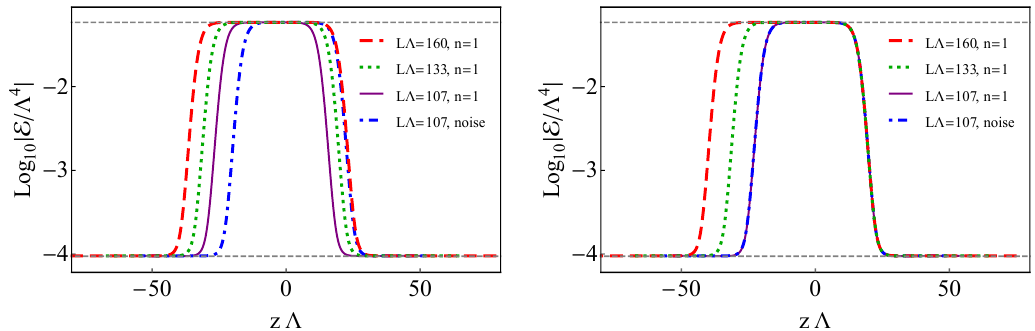
Figure 28 . (Left) Energy densities in the (cid:12)nal, phase-separated con(cid:12)gurations for several simula- tions with the same initial energy density E 2 and di(cid:11)erent box sizes L (cid:3) = 107 (triggered either by an n = 1 mode or by pure numerical noise) and L (cid:3) = 133 ; 160 (triggered in both cases by an n = 1 mode). The horizontal dashed lines indicate the high energy and low energy stable phases obtained from thermodynamics. (Right) Same curves as in (Left) shifted to the right by a constant amount to exhibit the fact that the shape of the interface is the same in all